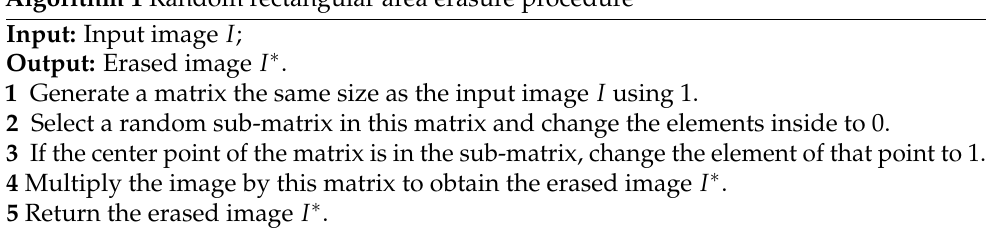
Figure 4. The image augmentation methods of our proposed framework. Algorithm 1 Random rectangular area erasure